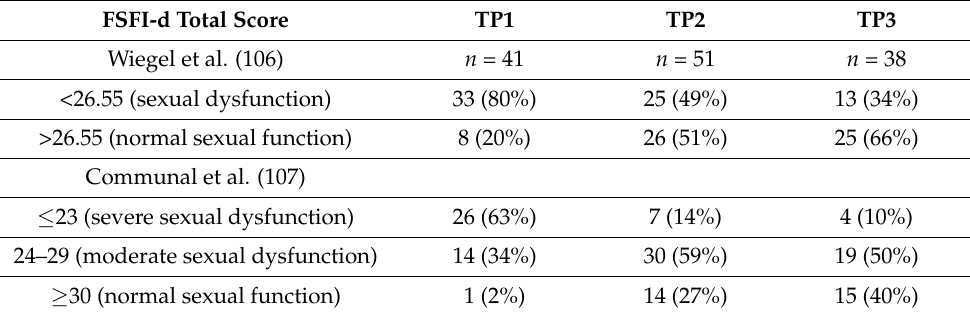
Table 10. Frequency and percentages of the FSFI-d total scores representing grades of sexual